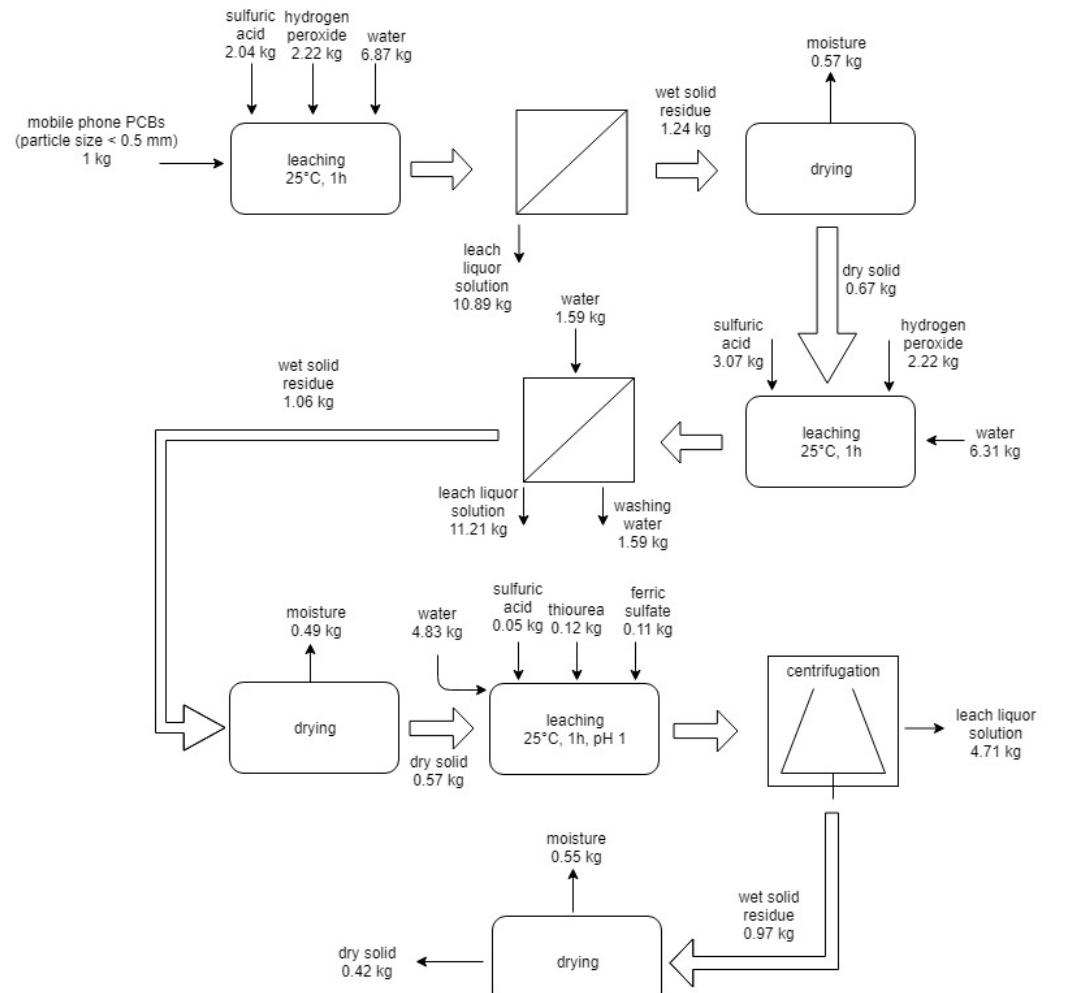
Figure 5. Flowsheet and mass balance of the first route process for the treatment of 1 kg of end-of-life mobile PCBs.